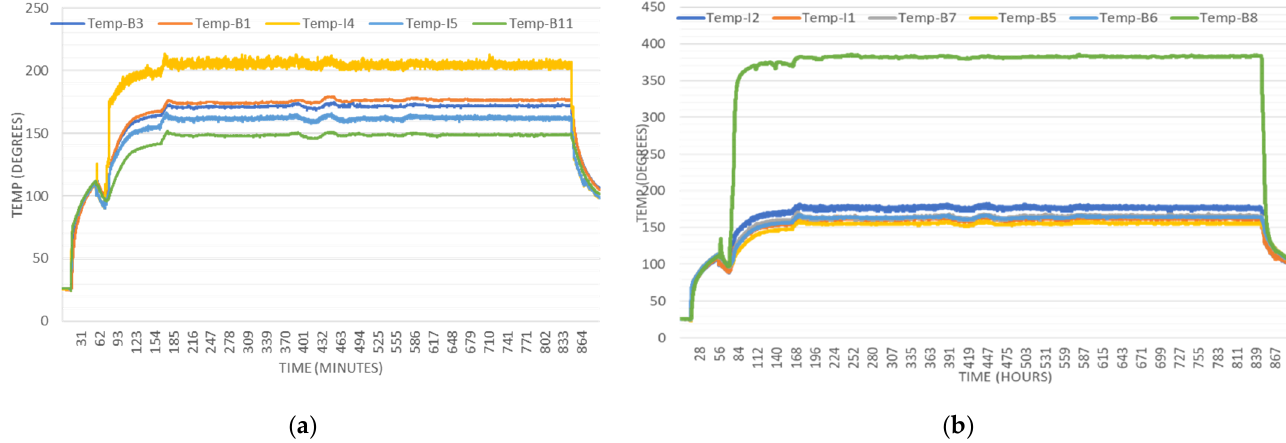
Figure 6. Temperature distribution at receiver’s surface ( a ) Left and Right panels ( b ) Central panel.